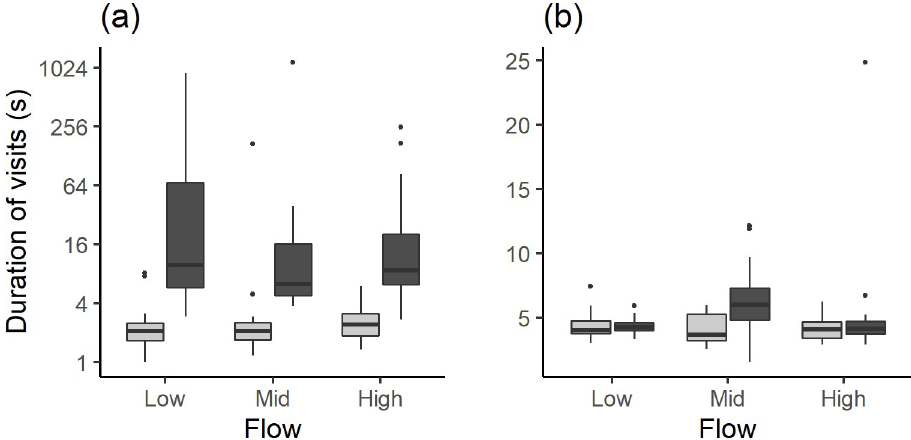
Fig 4. Median Duration of visits to the central zone for the control (light grey) and visual cue treatment (dark grey) at the three flow velocities for (a) common minnow and (b) brown trout. Note the difference in y-axis scale—the scale for minnow has been log